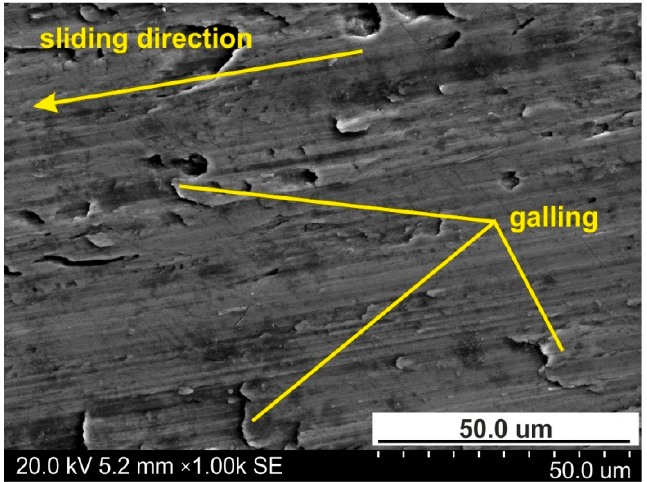
Figure 13. The specimen surfaces tested at 139 MPa in dry friction.